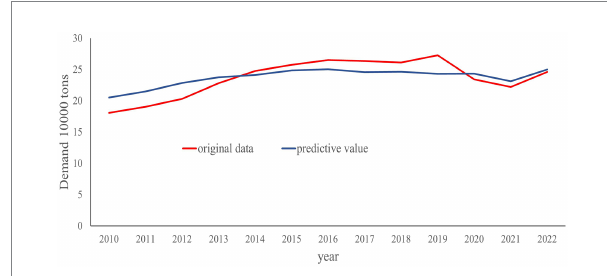
FIGURE 2 Fitting diagram of principal component regression prediction.